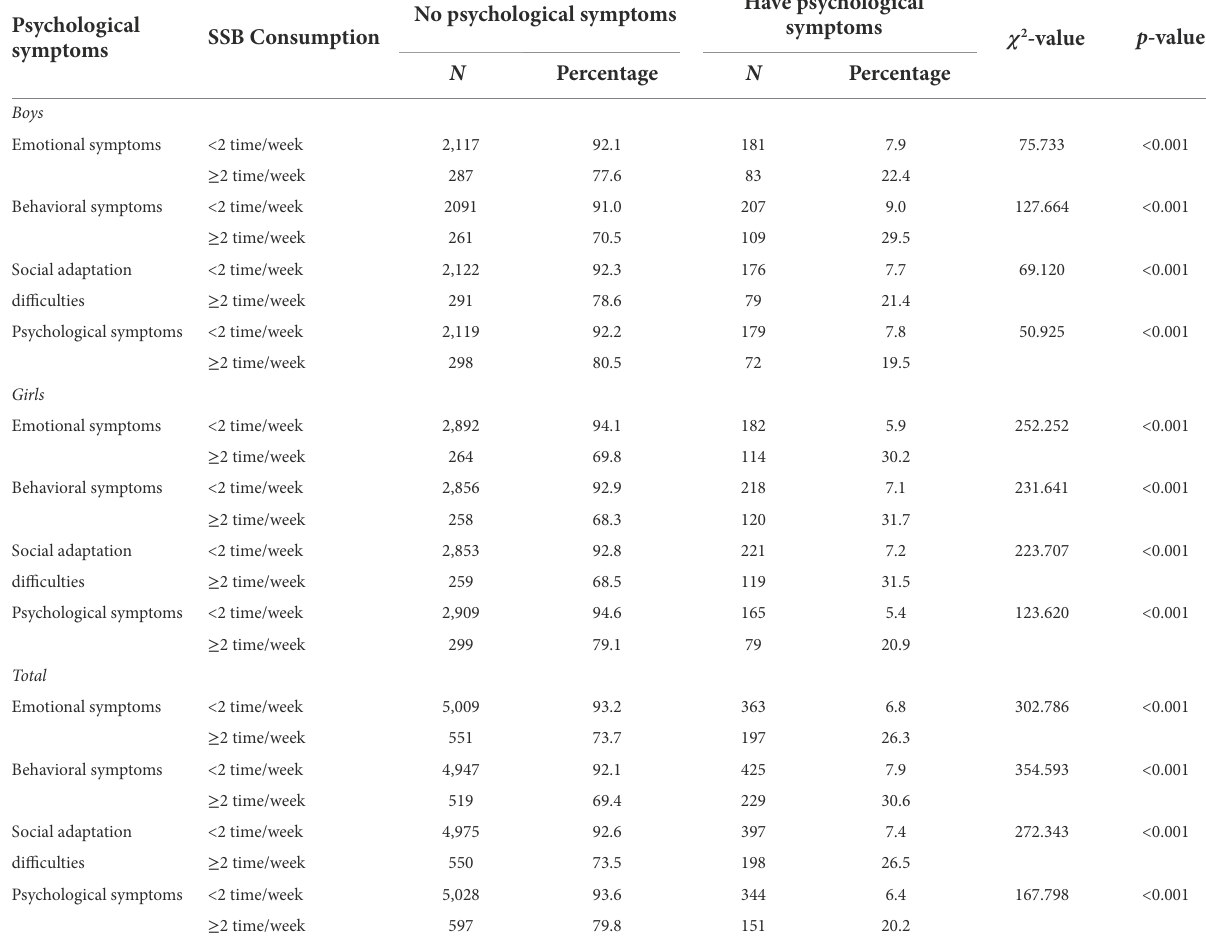
TABLE 2 Comparison of the detection rate of psychological symptoms among college students with different SSB consumption in China.